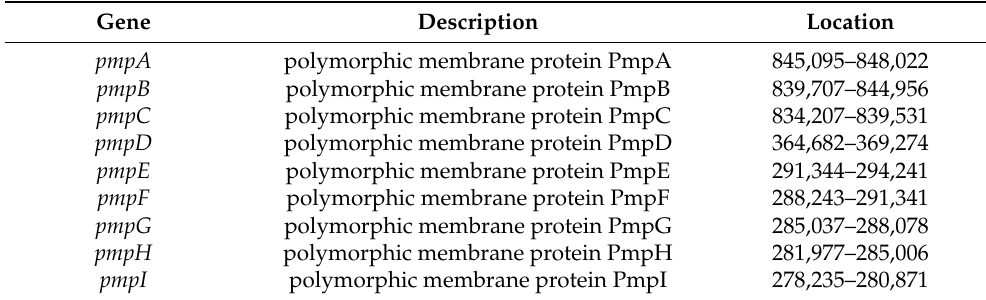
Table 1. List of genes encoding for Pmps. Respective locations on the LGV/17 strain chromosome are shown.